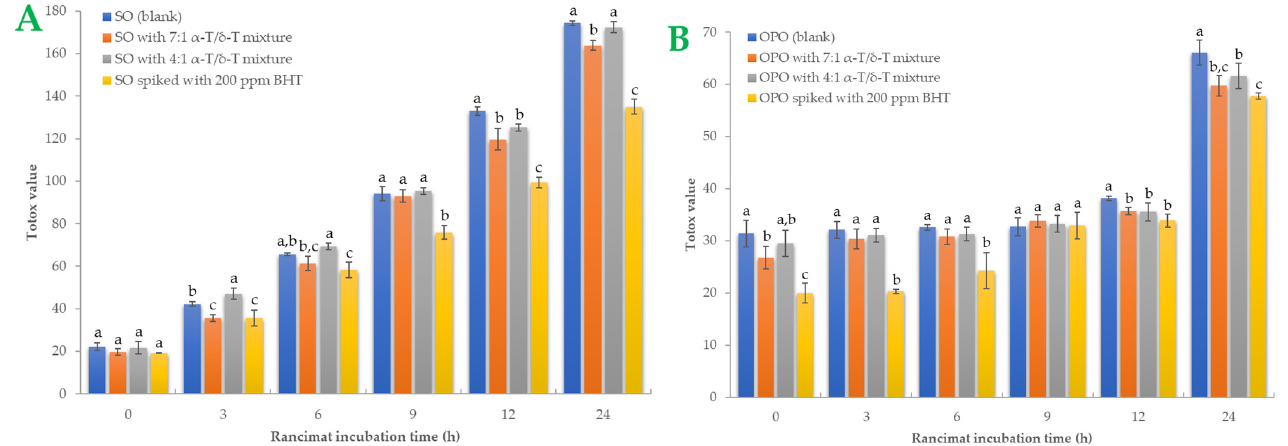
Figure 3. Sunflower oil (plot A ) and olive pomace oil (plot B ) samples’ Totox values during Rancimat incubation are shown. Standard deviation is shown with error bars, and means with different superscript letters (e.g., a–c) are statistically significantly different ( p < 0.05) for the same Rancimat incubation time.